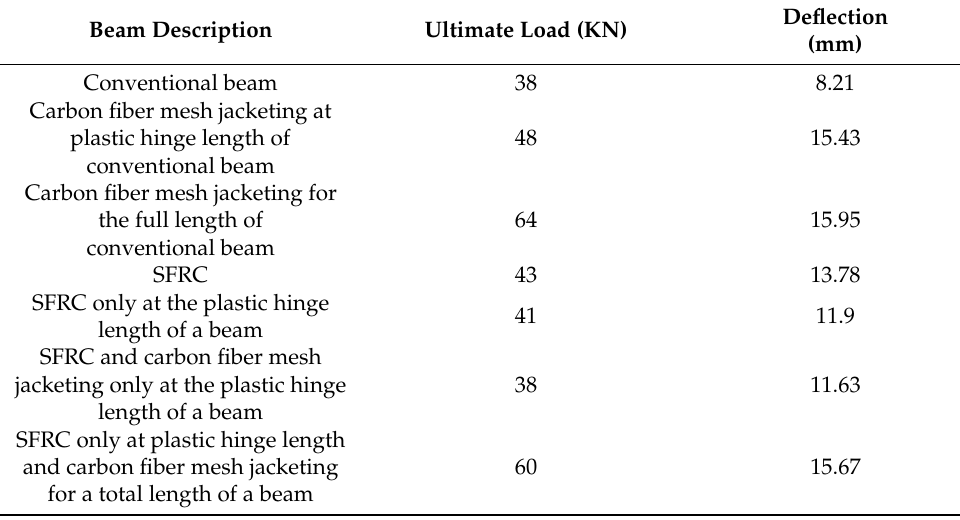
Figure 12. Experimental setup ( a ) Conventional Beam, ( b ) SFRC beam, ( c ) SFRC only at plastic hinge length of a beam, ( d ) Carbon fiber mesh jacketing at plastic hinge length of a conventional beam, ( e ) SFRC and carbon fiber mesh jacketing only at a plastic hinge length of a beam, ( f ) Carbon fiber mesh jacketing for a total length of a conventional beam, ( g ) Carbon fiber mesh jacketing for total length with SFRC at plastic hinge length of a beam. Table 10. Ultimate load and defection of beams.